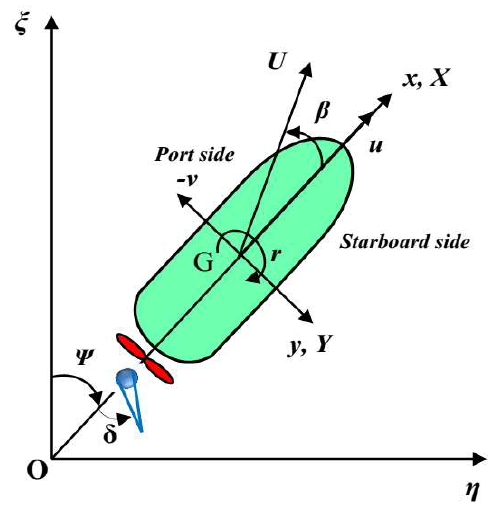
Figure 1. The ship coordinate system.